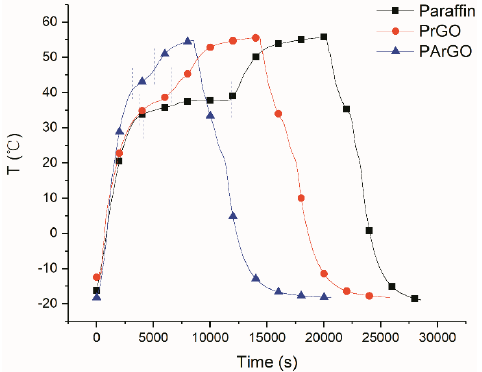
Figure 7. Schematic diagram simulating actual temperature changes. Figure 8. Phase transition curves of composite PCMs and paraffin in an environment simulating Figure 8. Phase transition curves of composite PCMs and para ffi n in an environment simulating actual actual temperature changes. temperature